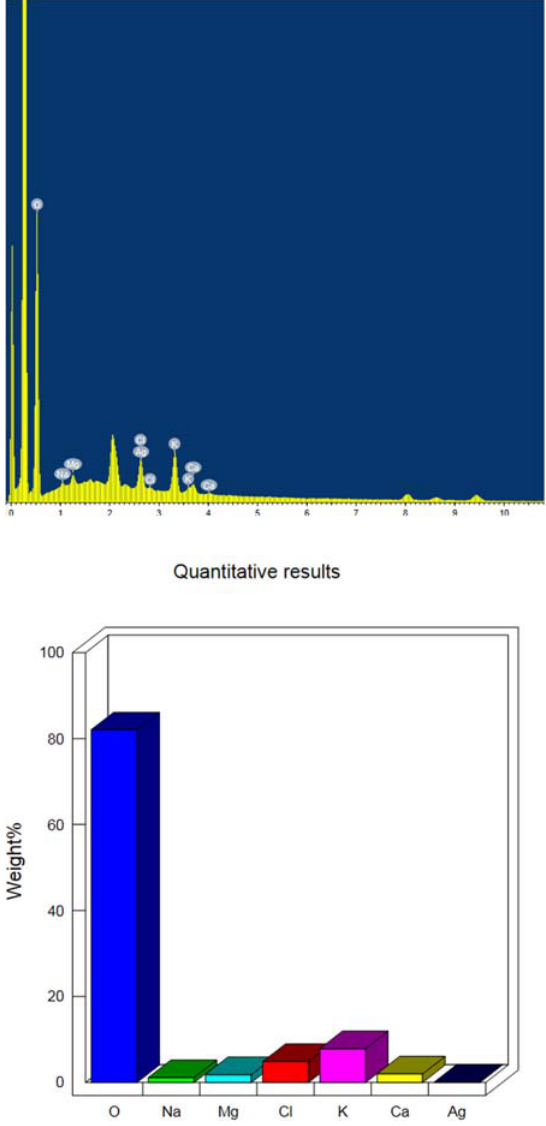
Figure 5: EDX elemental analysis of the biosynthesized AgNPs prepared with aqueous R. o ffi cinalis leaf